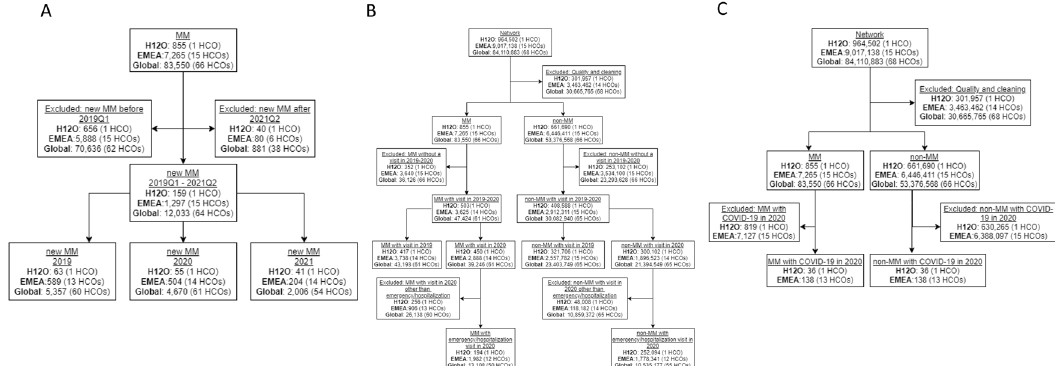
Fig. 1 Flow chart of the study. A Diagram of the cohorts used for the analysis of newly diagnosed multiple myeloma (MM) cases in 2019 and 2020. B Diagram of the cohorts used for the analysis of COVID-19 cases in MM and non-MM patients. C Diagram of the cohorts used for the COVID-19 analysis of mortality analysis (MM vs non-MM) between the fi rst and the second half of